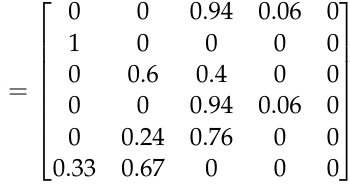
Table 6. Correlation between the evaluation score and other indices data.